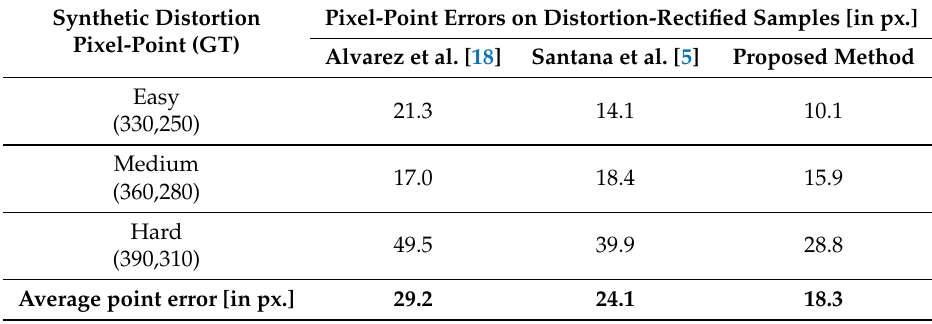
Table 3. Quantitative analysis: pixel-point error metrics on synthetic distorted